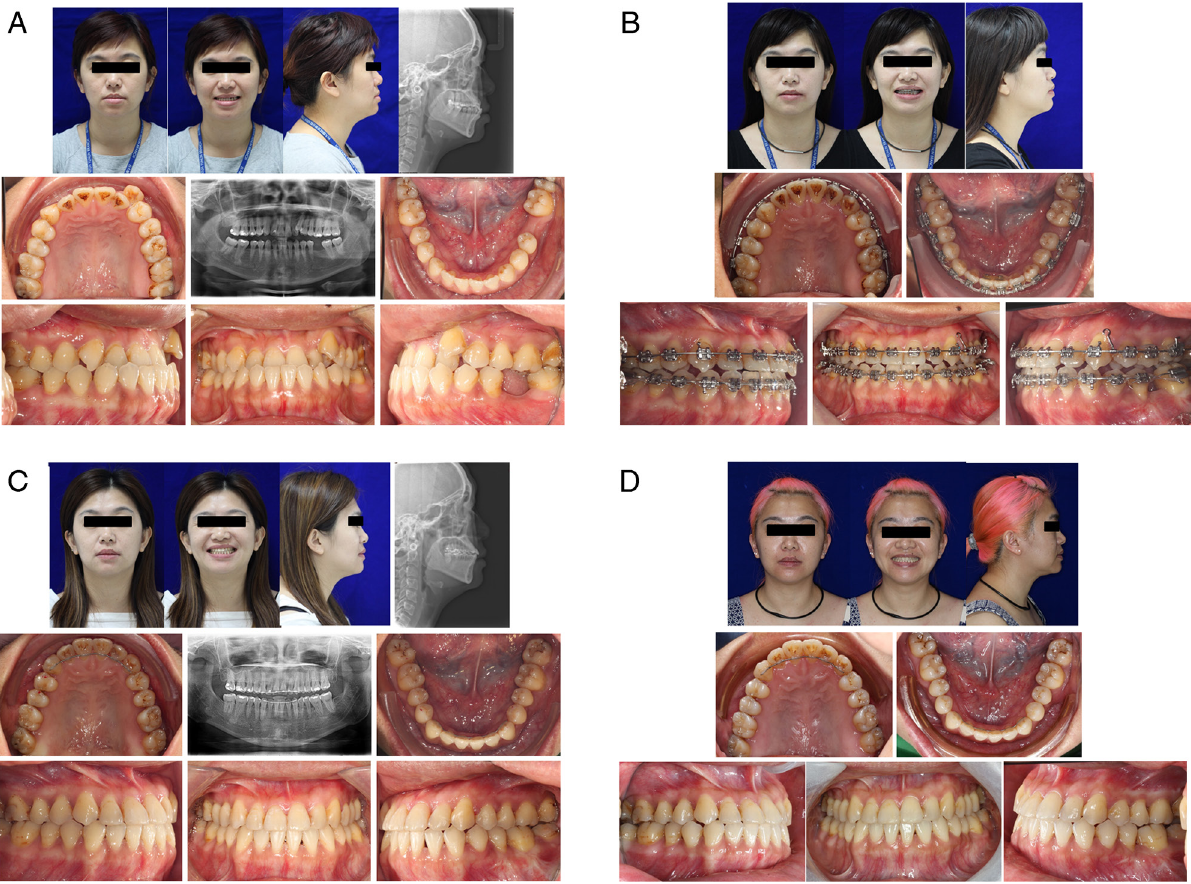
Figure 4. Case 2: (A) 37-year-old female patient with a skeletal Class III relationship, hypodivergent face pattern, anterior crossbite, and insufficient tooth display. Missing bilateral mandibular first molars with an atrophic ridge. (B) Space closure of the mandibular first molar areas, and bilateral uprighting of the mandibular second and third molars after GBR with an autogenous bone block (C) Patient after 28 months of treatment. (D) One year follow up records showed stable results without space